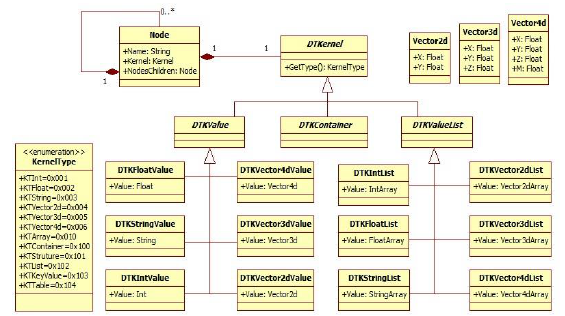
Finger 2: UML diagram of UDX object model